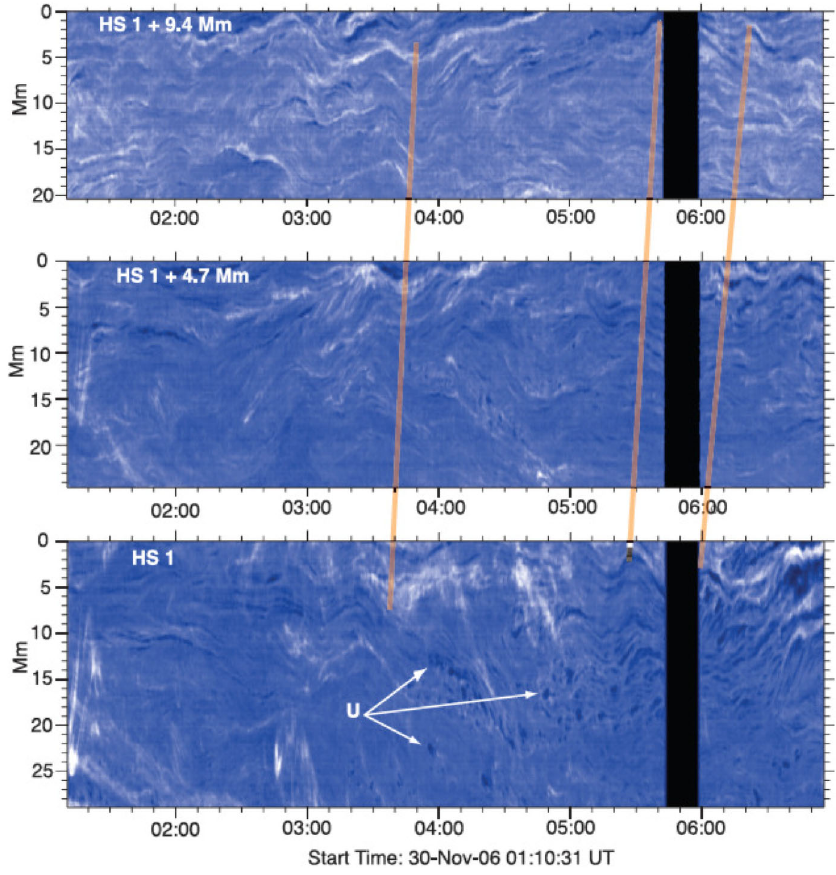
Fig. 7 Time slices taken at three heights in a quiescent prominence. The bright sinusoidal patterns are causedbyhorizontaloscillationsoftheplasmawithperiodsbetween20and40min.Theorangelinesdenote oscillations with phases that approximately match. The slope of these lines implies an upward propagation speed of about 10 km s − 1 (projected on the plane of the sky). Image reproduced with permission